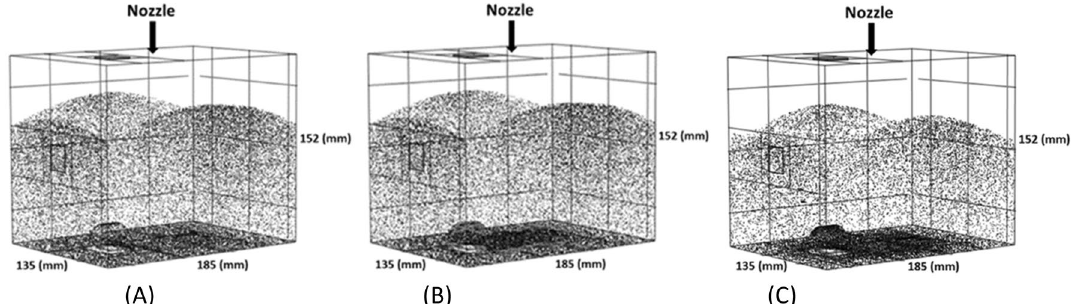
Figure 13. Visualization of aerosol droplet deposition with varying the viscosity of liquid the CFD box model, ( A ) Saline (NaCl 0.9%), ( B ) Icodextrin 4%, and ( C ) Icodextrin 7.5%. The black dots represent the deposited aerosol droplets. With increasing the viscosity of liquid, more aerosol droplets deposited at the bottom region of the box model (dorsal